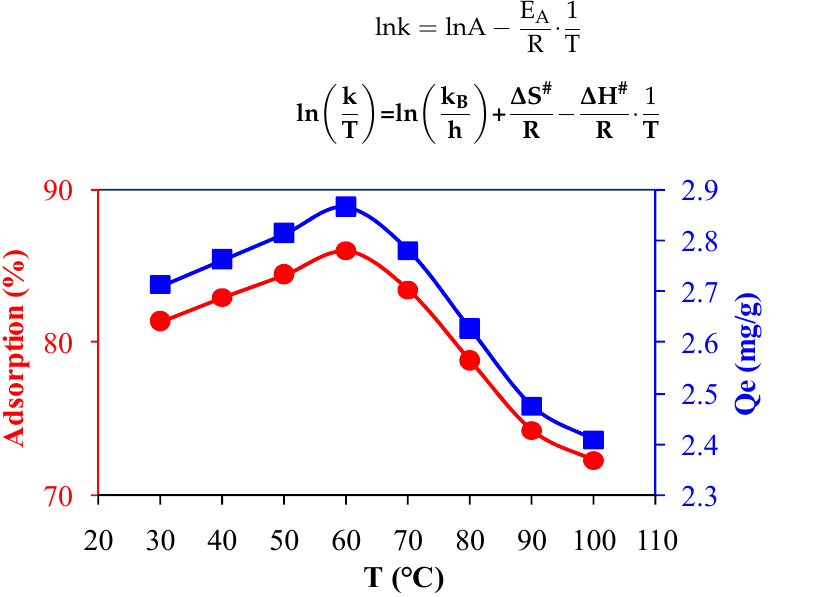
Figure 9. Effect of temperature on the biosorption of RBV-5R using SCB at 20 µg/mL RBV-5R, pH 6, 0.15 g SCB, and contact time of 60 min.